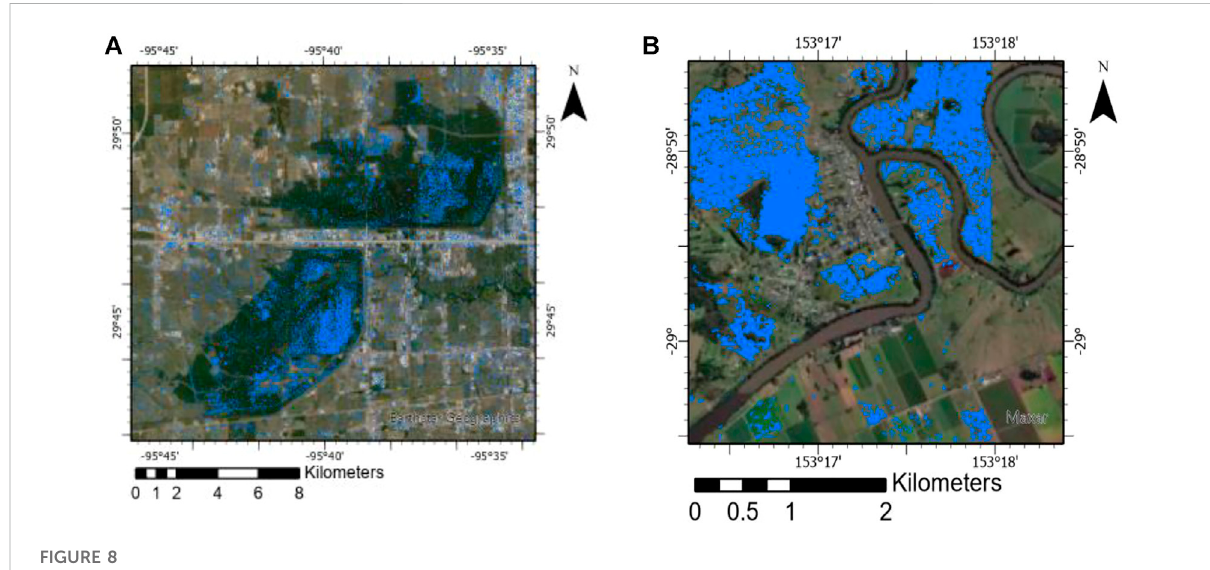
FIGURE 8 Benchmark fl ood maps of (A) Houston and (B)